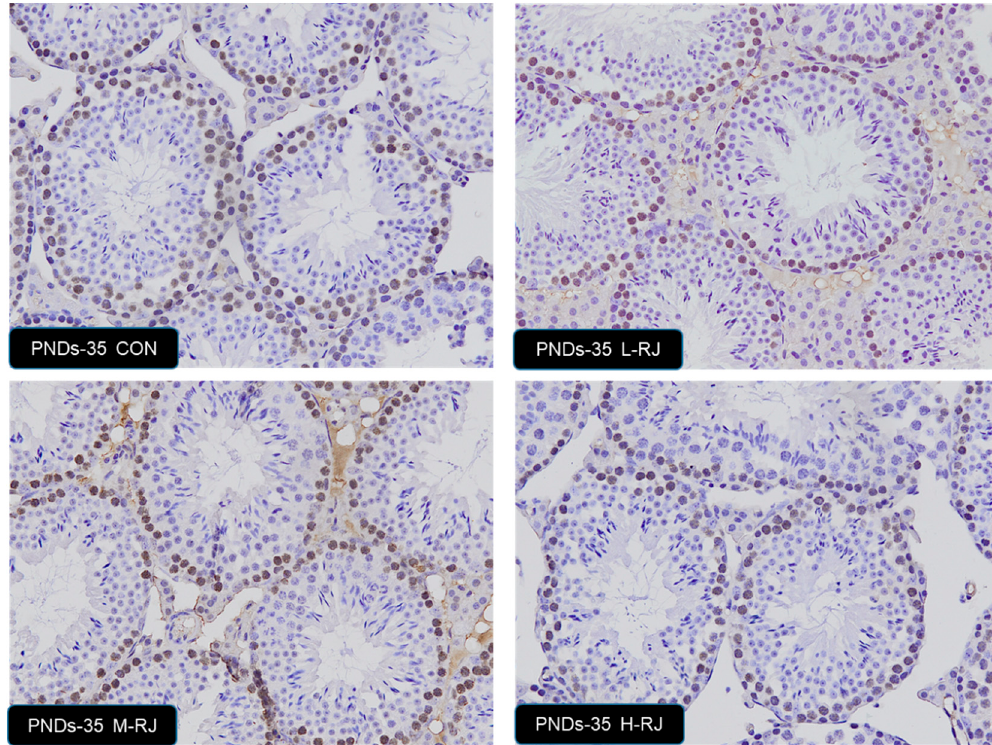
Figure 7. The IHC for PCNA of the testis of CON and treatment groups PNDs 35. We also detected apoptotic cells at PNDs 07, PNDs 14 and PNDs 21. However, there was no obviously significant differences among the groups in mentioned organ (data not shown). Magnification: 20x. The number of PCNA-positive germ cells were detected by IMAGE-PRO 6.0 and was analyzed by SPSS 20.0 (Version 20.0).